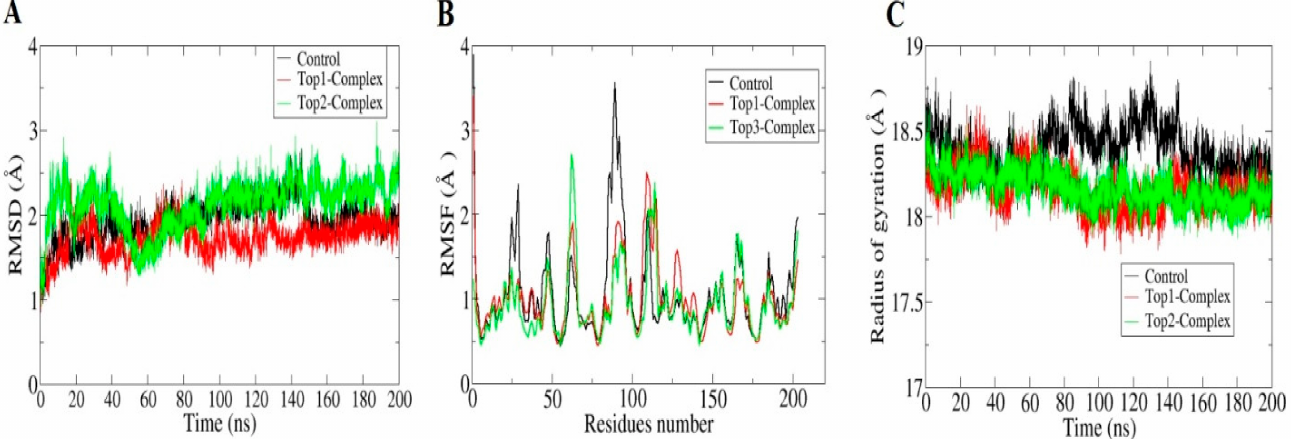
Figure 3. Molecular dynamics simulation trajectories analysis to evaluate the stability of the complexes’ dynamics as a function of time. ( A ) RMSD analysis. ( B ) RMSF analysis sand radius of gyration analysis ( C ) of MvfR in the presence of co-crystallized control, Top1 and Top2